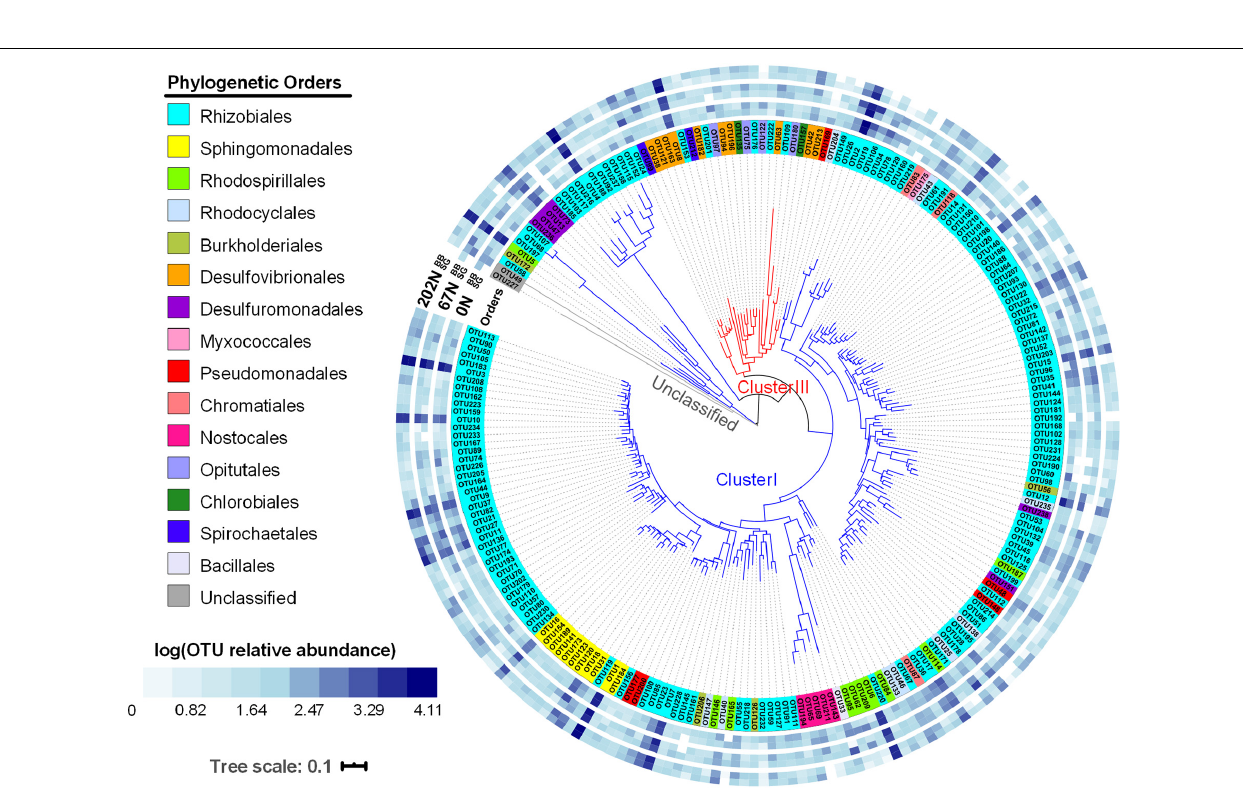
Frontiers in Microbiology |